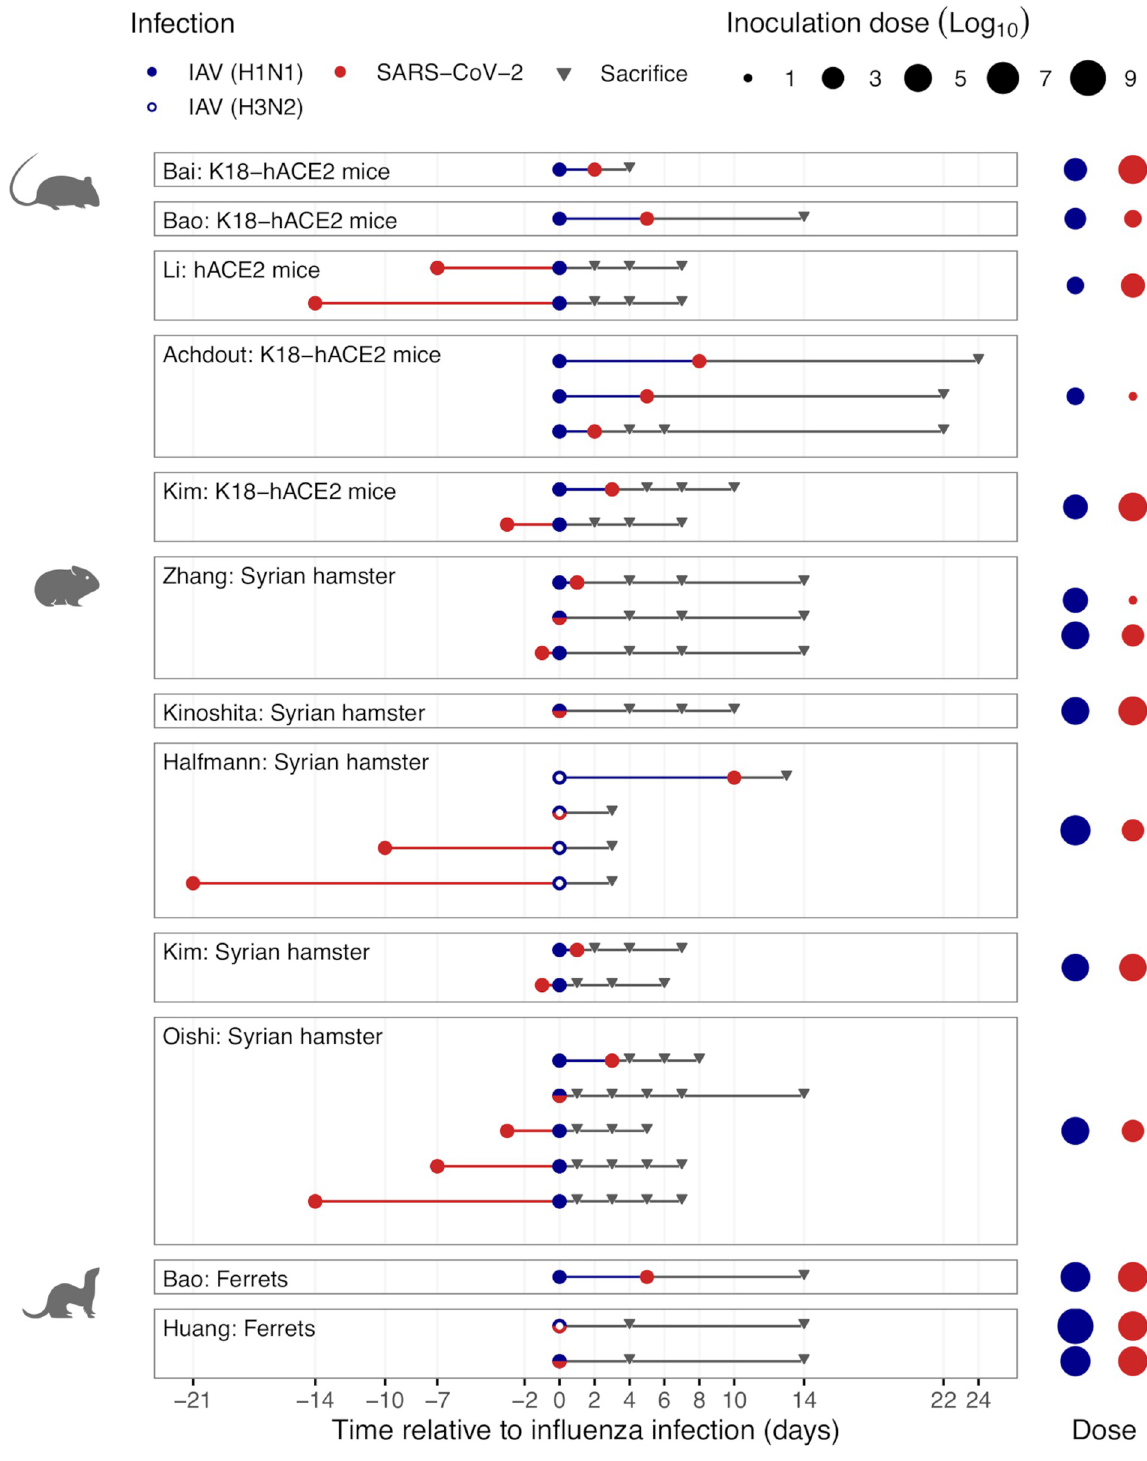
Fig 2. Experimental designs of animal studies assessing the interaction between SARS-CoV-2 and influenza A virus (IAV). [44–54]. The protocols of the experiments in mice, hamsters, and ferrets were summarized to allow comparison across studies. Red points represent the time point for infection with SARS-CoV-2 and blue points for infection with IAV (filled points represent infection with IAV (H1N1) and empty points with IAV (H3N2)). Triangles represent the time at which samples from sacrificed animals were taken. The data from every study were extracted from the text, the tables, or the figures; all the corresponding values were checked and are available in S1 and S2 Tables.